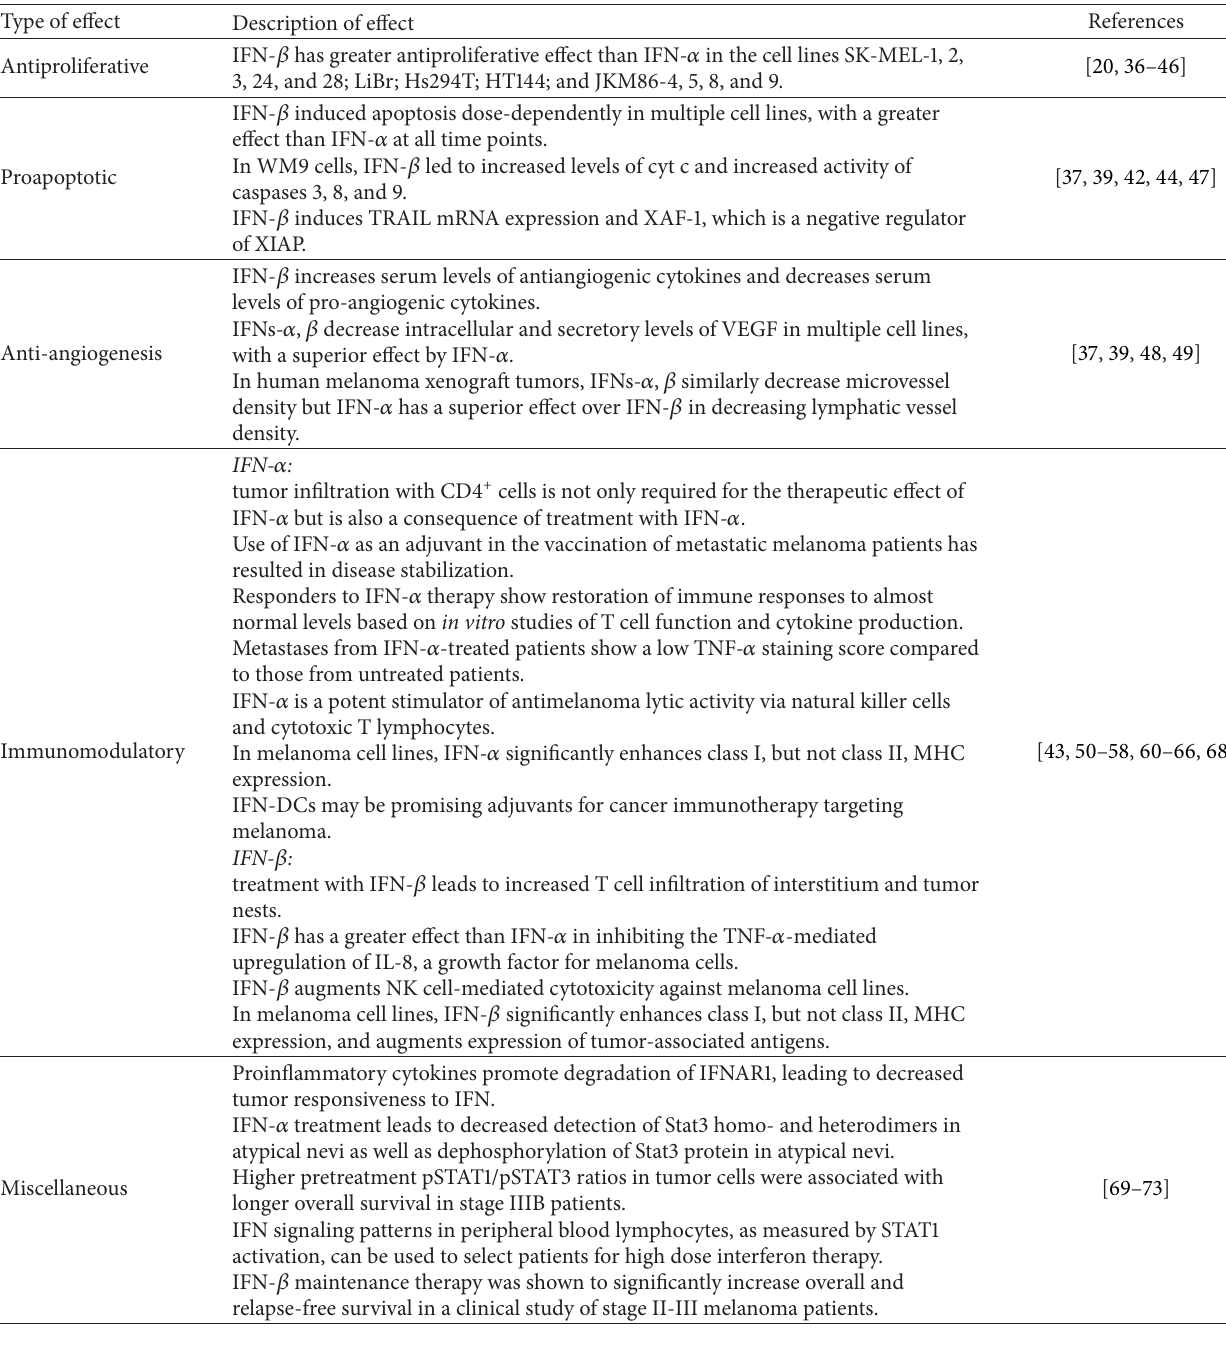
Table 4: Effect of type I interferon on